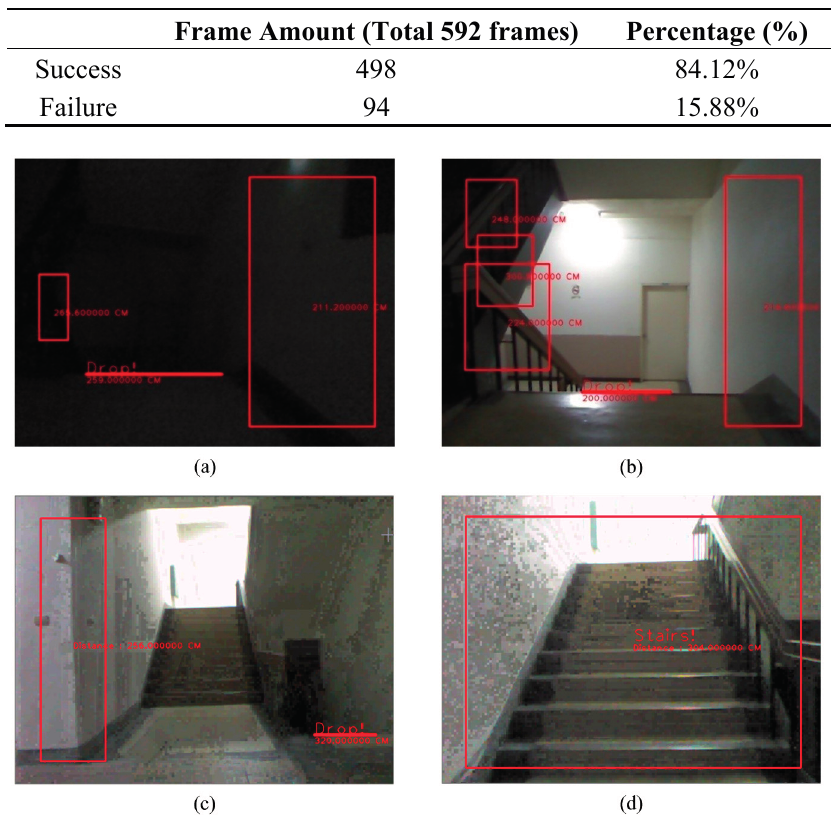
Table 5. The success rate and failure rate for detection of descending stairs.